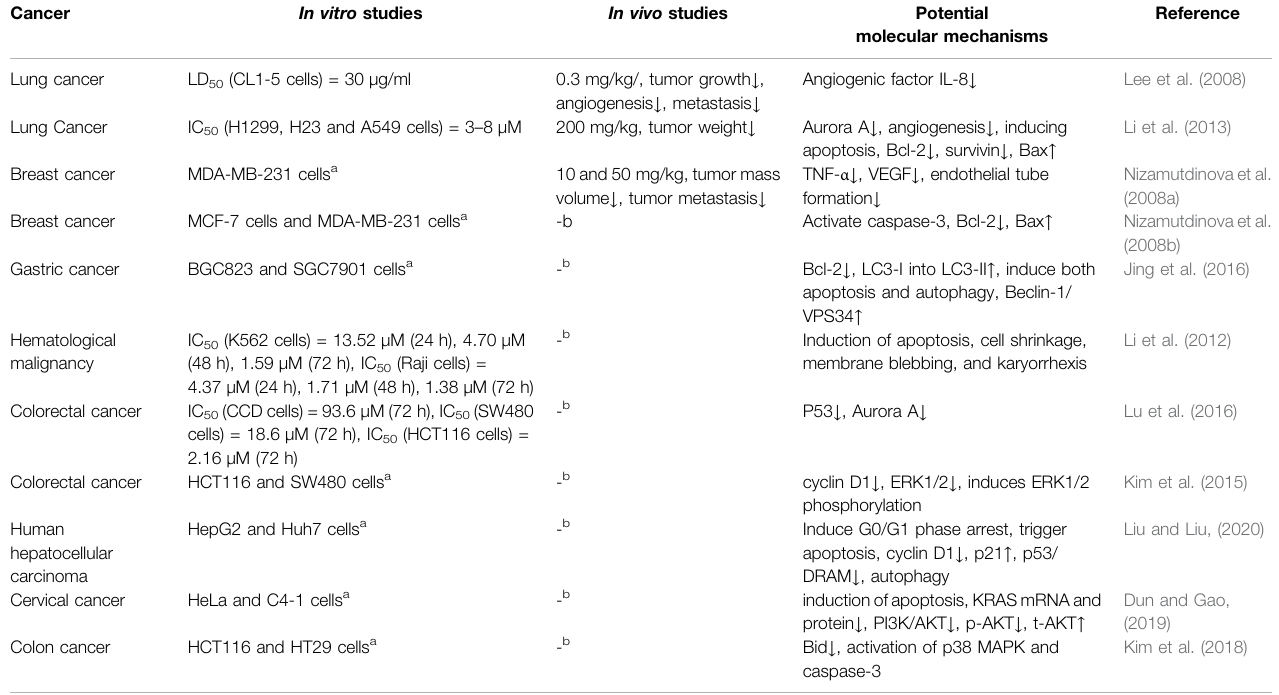
TABLE 1 | Summary of in vitro and in vivo studies with tanshinone I against various